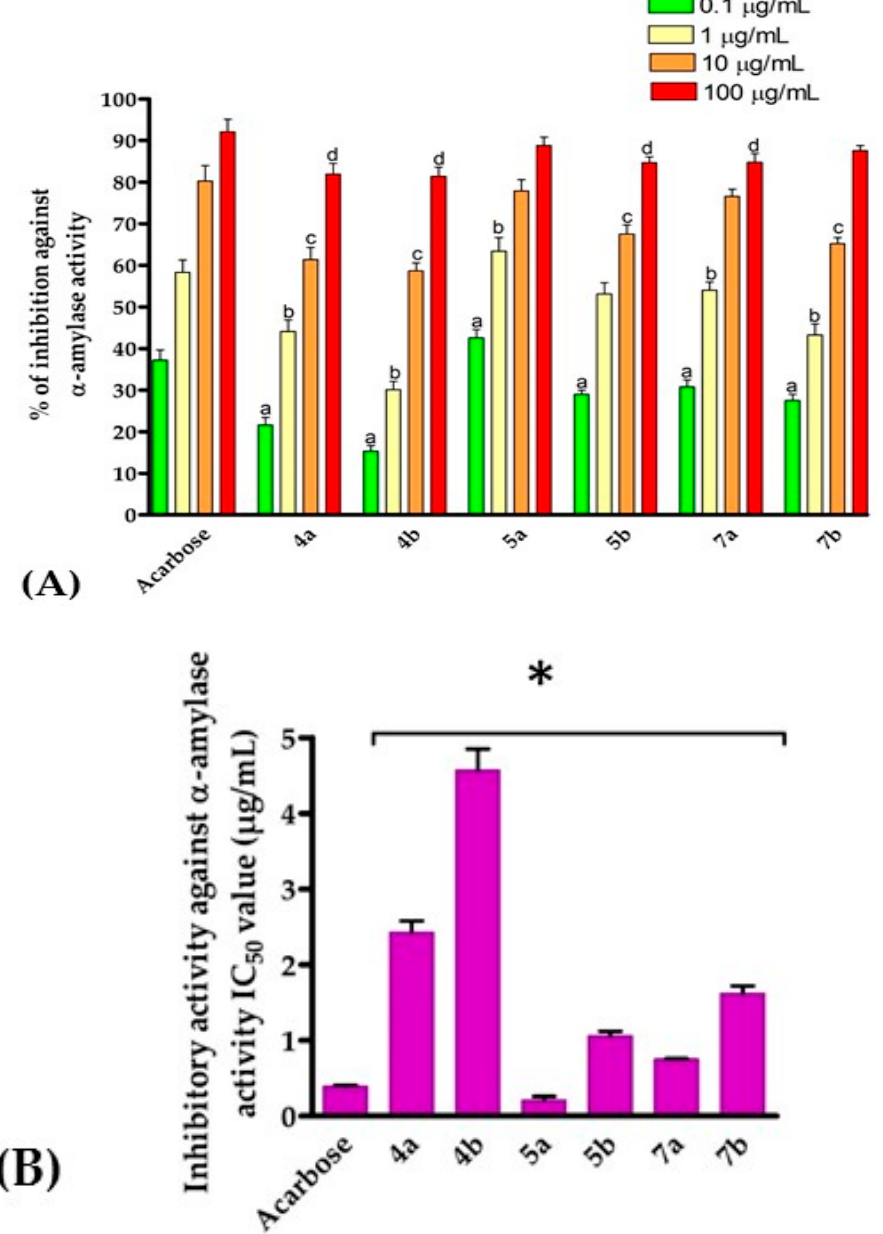
Figure 4. Inhibitory activity of compounds 4a – b , 5a – b , and 7a – b against α -amylase activity (n = 4). ( A ) Percentage of inhibition. ( B ) IC 50 values ( µ g/mL). Data are presented as mean ± SD. a p < 0.05 versus acarbose at concentration 0.1 µ g/mL, b p < 0.05 versus acarbose at concentration 1 µ g/mL, c p < 0.05 versus acarbose at concentration 10 µ g/mL, d p < 0.05 versus acarbose at concentration 100 µ g/mL,* p < 0.05 versus acarbose for the IC 50